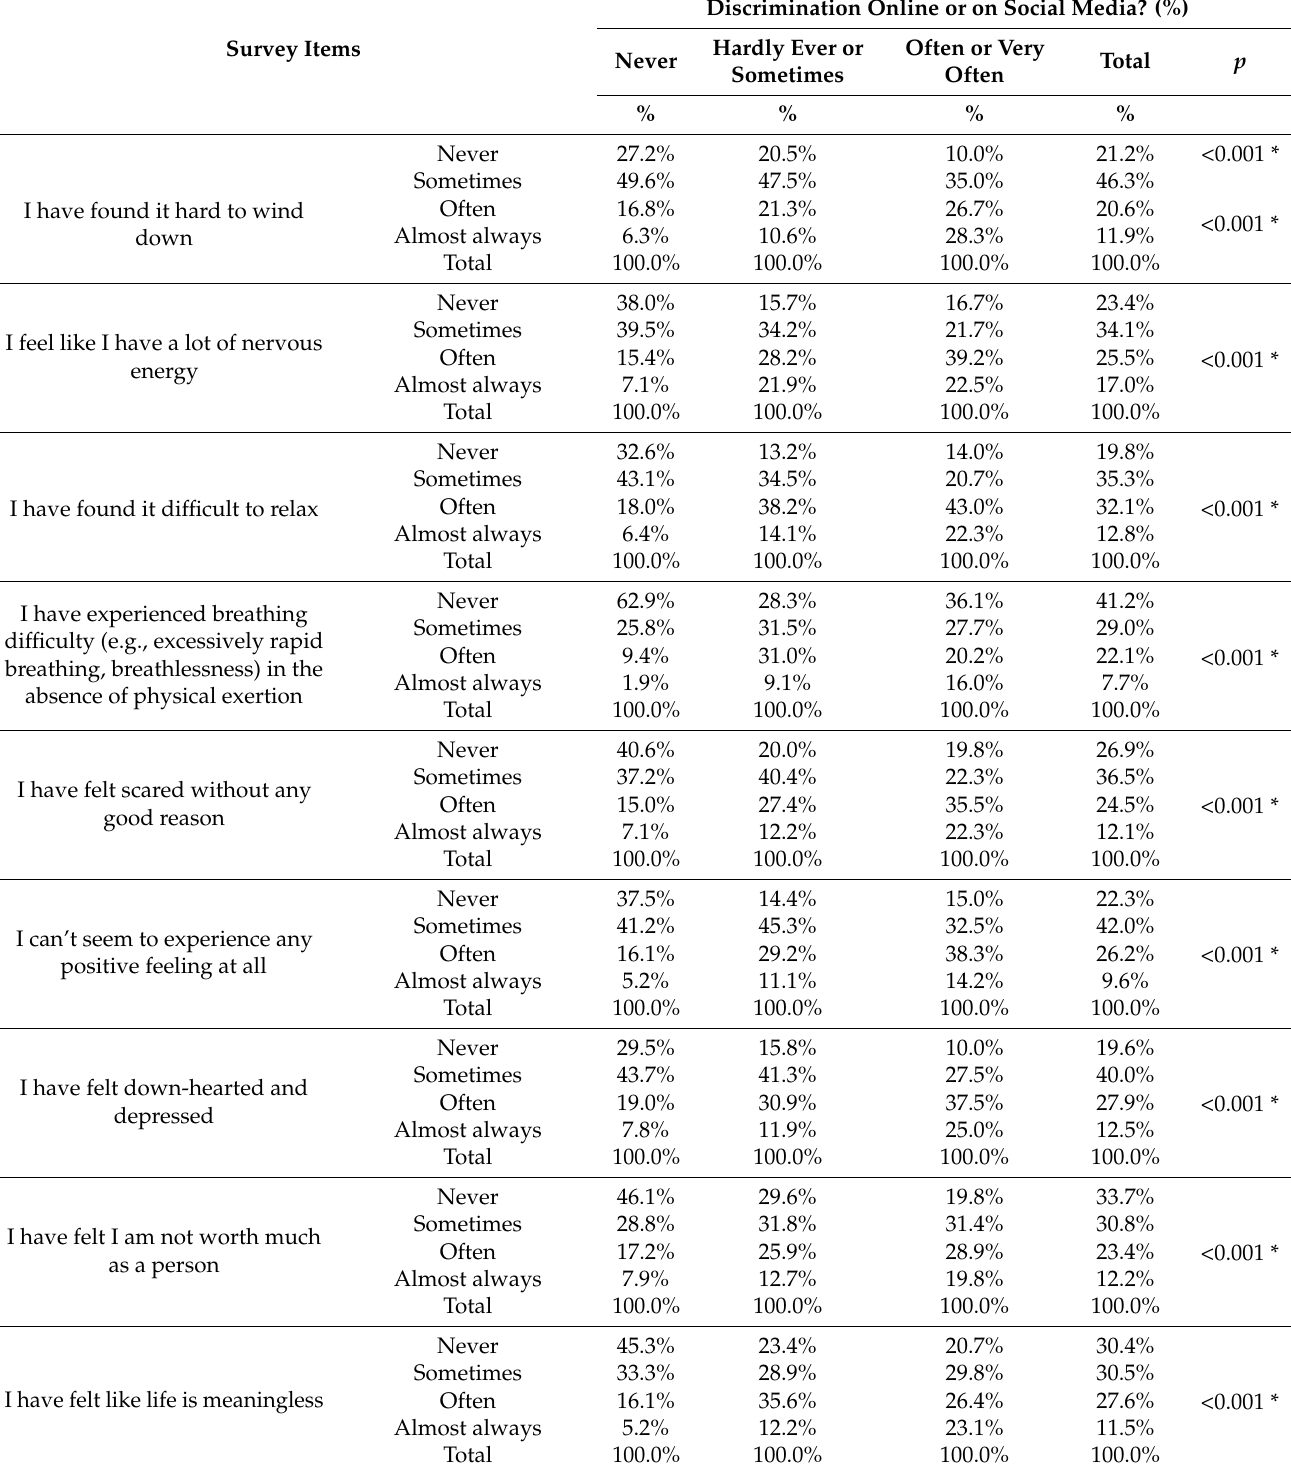
Table 4. Mental health and wellbeing by experiences of online racism during the COVID-19 pandemic, n =